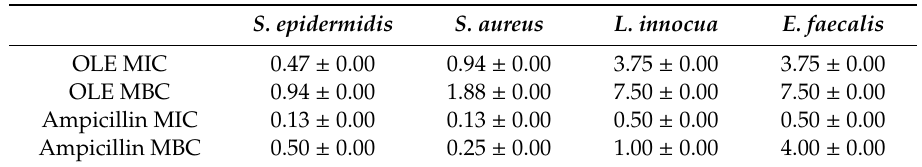
Table 2. Minimum inhibitory (MIC) and minimum bactericidal (MBC) values of OLE and the reference antibiotic ampicillin expressed as mg / mL ± SD ( n =